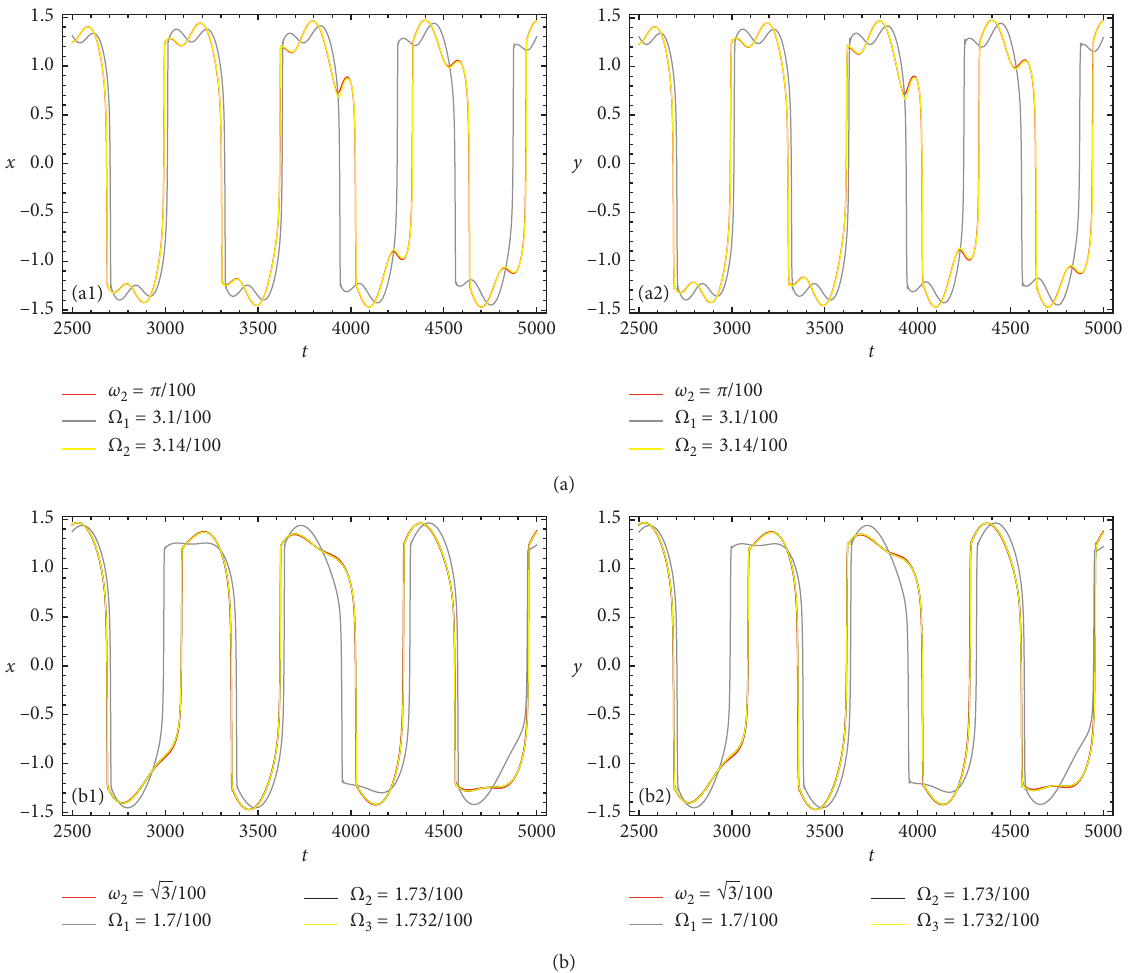
Figure 12: Bursting pattern with incommensurate excitation frequencies (red curve) agrees well with the one with truncated, commensurate excitation frequencies (yellow curve).